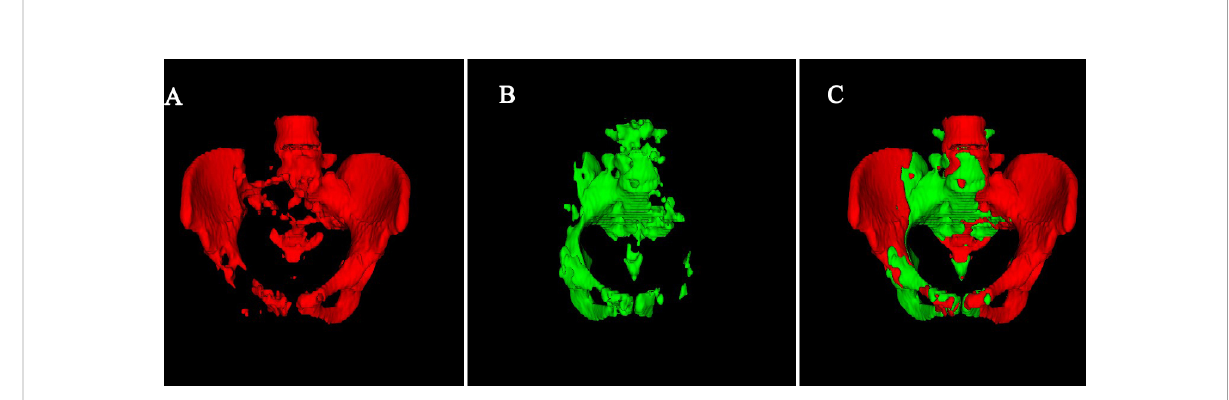
FIGURE 1 A case of BM ACT and BM TOT distribution. (A) Red indicates that bone SUV is lower than the average SUV of the patient ’ s individual mean SUV. (B) Green indicates that bone SUV is greater than or equal to the average SUV of the patient ’ s individual mean SUV. (C) Total volume of Pelvic